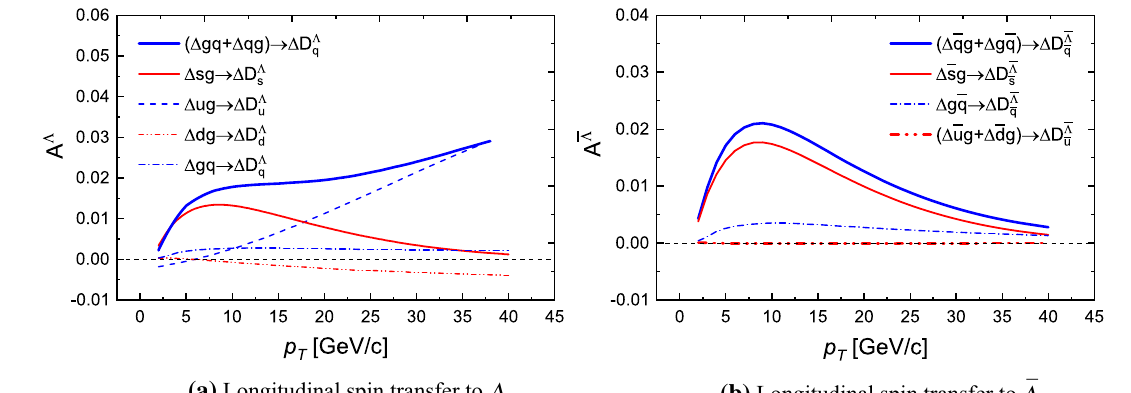
Fig. 3 The calculated spin transfers to Λ and ¯ Λ of quarks and gluon for the channel Δ sg → Δ D Λ s . The channels for the polarized u (the √ s = 200GeV. The thick solid curves rep- for positive η versus p T at dashed curves) and d (the dashed dot dot curves) quarks, and g (the dashed dot curves) are also shown in the resent the total contributions from the polarized quarks/antiquarks and gluon, and the thin solid curves represent the spin transfer of the s quark